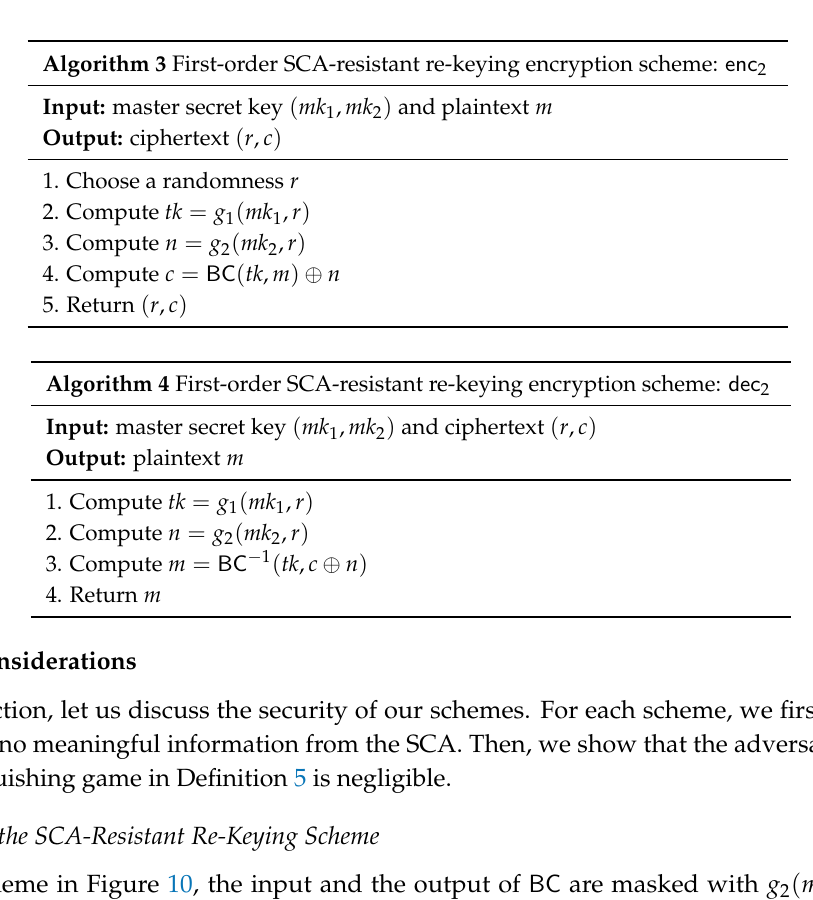
Figure 11. First-order SCA-resistant re-keying encryption scheme.